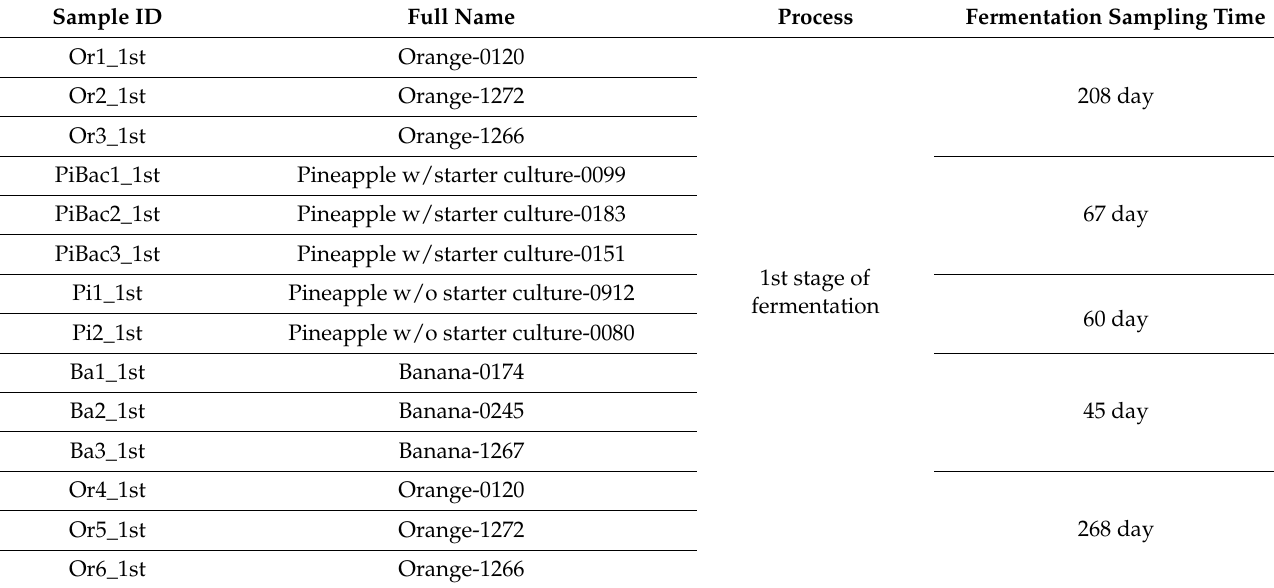
Table 1. Description of samples and fermentation processes based on raw materials and fermentation